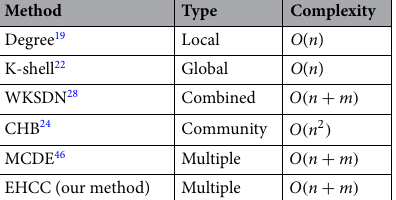
Table 5. The proposed method and five well-known